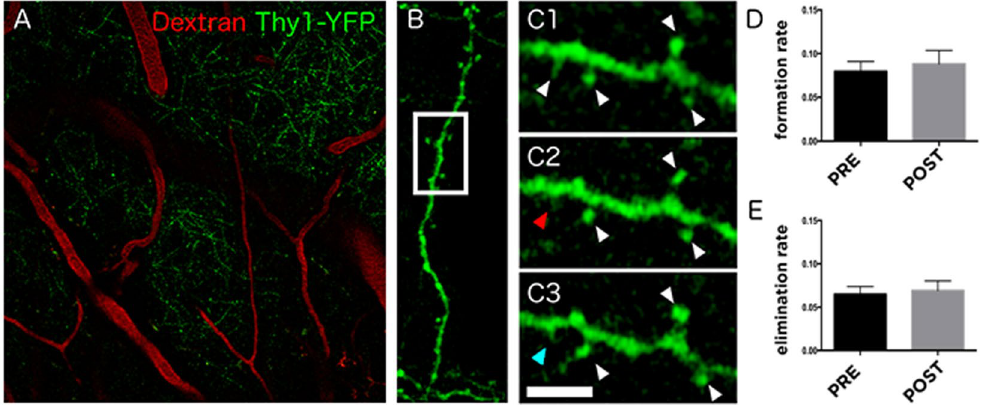
Figure 6. Effects of isoflurane on dendritic spine turnover in the somatosensory cortex of awake mice. ( A ) Focal plane showing expression of YFP under the thy1 promoter and the 70 kDa dextran tracer labeled with Texas Red which serves as map to identify the same areas during the different time points of the experiment. ( B ) Reconstruction of confocal images showing one of the dendritic segments analyzed. ( C ) Selected area shows a high magnification image of the dendrite to illustrate the spines (C1) 24 hours before, (C2) immediately before and (C3) 24 hours after the isoflurane administration (30 min). White arrowheads indicate stable spines, red arrowhead indicates eliminated spine and blue arrowhead indicates newly formed spine. Histograms represent ( D ) spine formation (p = 0.6476) and ( E ) elimination rate (p = 0.7301) before (pre-treatment) and after (post- treatment) isoflurane treatment. n = 3 mice, ~300 spines/mouse were analyzed. Scale bar size corresponds to